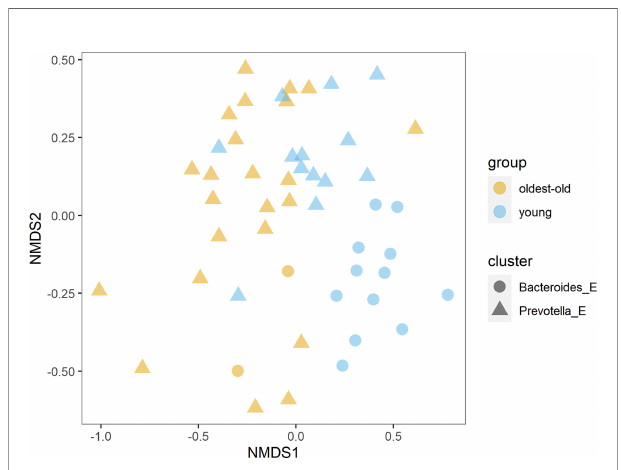
FIGURE 2 | Distribution of enterotypes in the oldest-old and young groups (NMDS, non-metric multidimensional scaling).